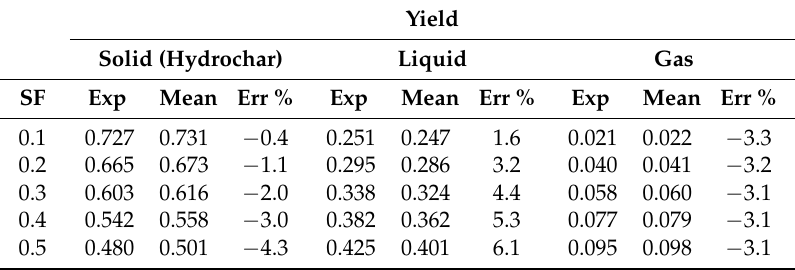
Table 6. Data refers to grape marc. The experimental values (EXP) were calculated by using the correlations of Figure 6c. The mean values (MEAN) were calculated by averaging the correlations of Figure